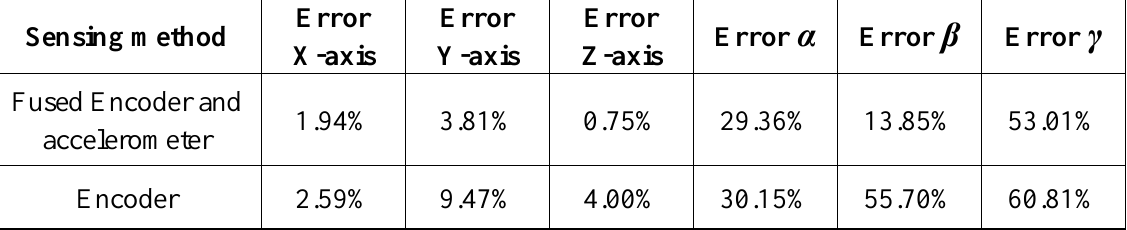
Table 6. Comparative of errors between encoder and fused encoder-acelerometer.